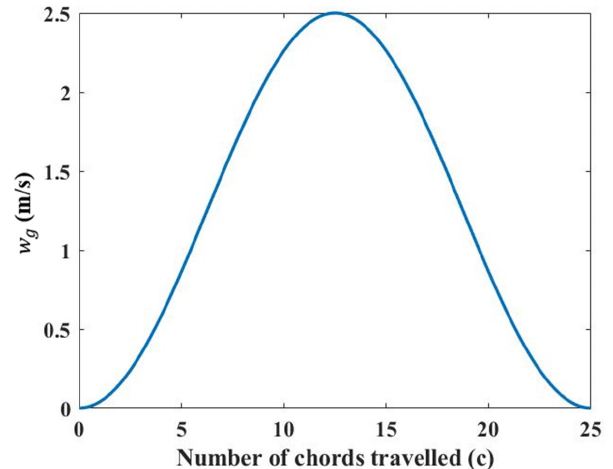
Figure 5. Vertical gust velocity profile for 1-cosine gust vs. gust gradient ( H ) in terms of number of chords travelled.